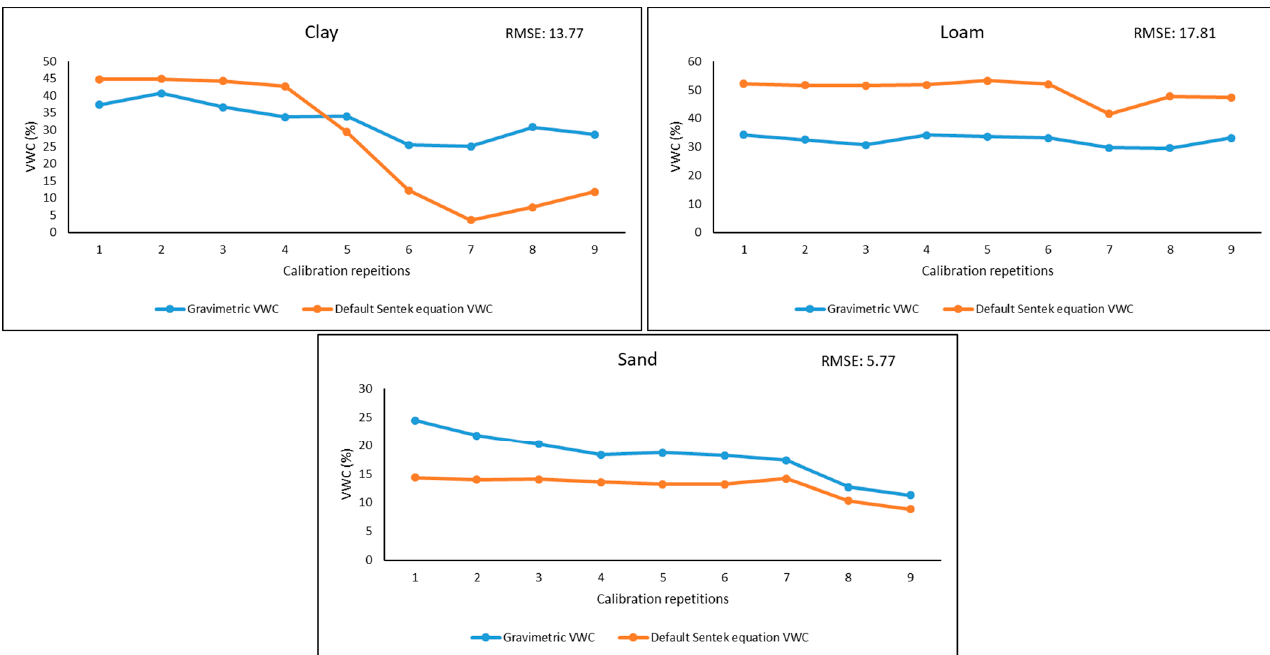
Figure 4. Gravimetric VWC (blue line) compared to VWC derived from default Sentek calibration equation (orange lines) for the nine dates.